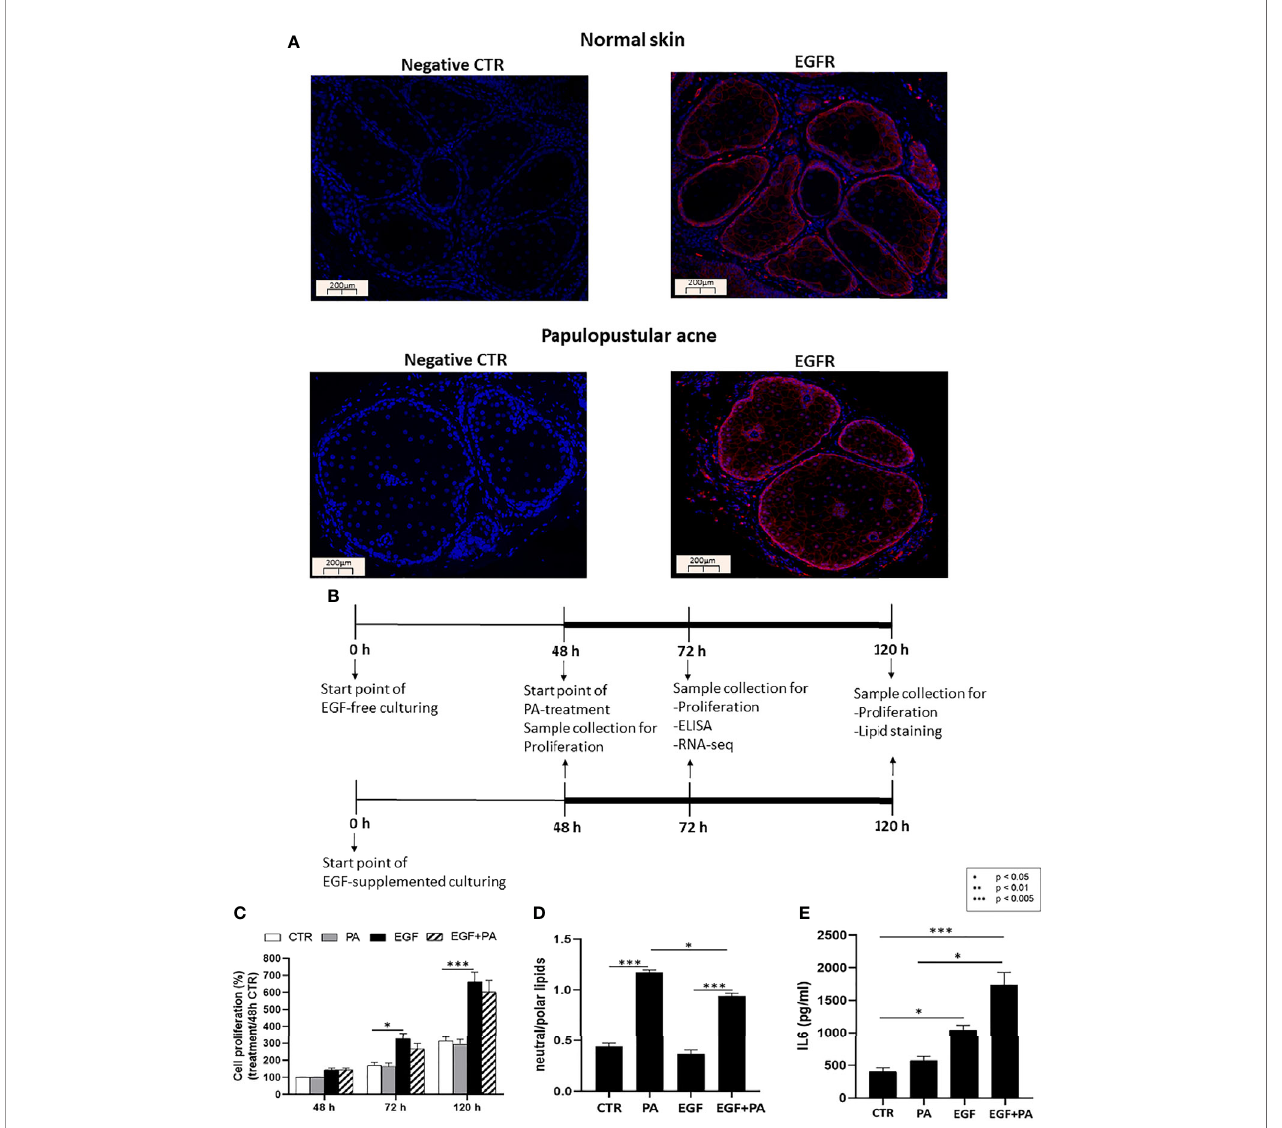
FIGURE 1 | EGFR is expressed in sebaceous glands of healthy and acne involved skin and EGF modulates proliferation, lipid production and in fl ammation in SZ95 sebocytes. (A) FFPE tissue samples were stained with an anti-EGFR rabbit polyclonal antibody as described in Materials and Methods. Note that similar staining intensities are observed in normal and in papulopustular acne skin samples, localizing to both the proliferating as well as the lipid producing layers of sebaceous glands. Negative controls were processed without using primary antibody. Slides were mounted with Vectashield mounting medium with DAPI. Scale bar = 200 µm. (B) SZ95 sebocytes were cultured in the presence or absence of EGF. At 48 hours 150 µmol/L PA or vehicle was added to the medium and SZ95 sebocytes were cultured for further 24 and 72 hours (marked as 72 h and 120 h). Samples were collected, processed, and measured as described in Materials and Methods at the relevant timepoints. (C) Sulforhodamine B assay was used as described in Materials and Methods to detect the rate of proliferating sebocytes cultured in the presence or absence of EGF for 48, 72 and 120 hours and treated with 150 µmol/L PA, at 48 hours timepoint. EGF signi fi cantly induced cell proliferation at 72 and 120 hours, whereas proliferation was tendentiously decreased after co-treatment with PA. Samples from three subcultures of SZ95 sebocytes were used for the experiments and three independent measurements were performed. SRB data were normalized to the absorbance of the 48 hours CTR samples which was taken for 100%. Two-way ANOVA and Tukey post-hoc tests were used in the analysis of SRB data. All data are presented as mean ± SEM. *p < 0.5, ***p < 0.005. (D) AdipoRed staining used to detect polar and neutral lipids as described in Materials and Methods in SZ95 sebocytes cultured in the presence or absence of EGF and treated with 150 µmol/L PA for 72 hours showed that EGF decreased PA-induced lipogenesis. Amount of neutral lipids are normalized with polar lipids, which correlate with cell numbers. Results are expressed as average of three independent measurements using samples from three subcultures of SZ95 sebocytes. Kruskal-Wallis test and Dunn post-hoc tests were used in the analysis of data. All data are presented as mean ± SEM. *p < 0.05, ***p < 0.005. (E) Supernatants from SZ95 sebocytes cultured in the presence or absence of EGF and treated with 150 µmol/L PA for 24 hours were used to determine the levels of IL6 by ELISA as described in Materials and Methods. Results are expressed as average of protein concentrations (pg/mL) of fi ve independent measurements using samples from three subcultures of SZ95 sebocytes. Kruskal-Wallis test and Dunn post- hoc tests were used in the analysis of ELISA data. All data are presented as mean ± SEM. *p < 0.05, ***p <